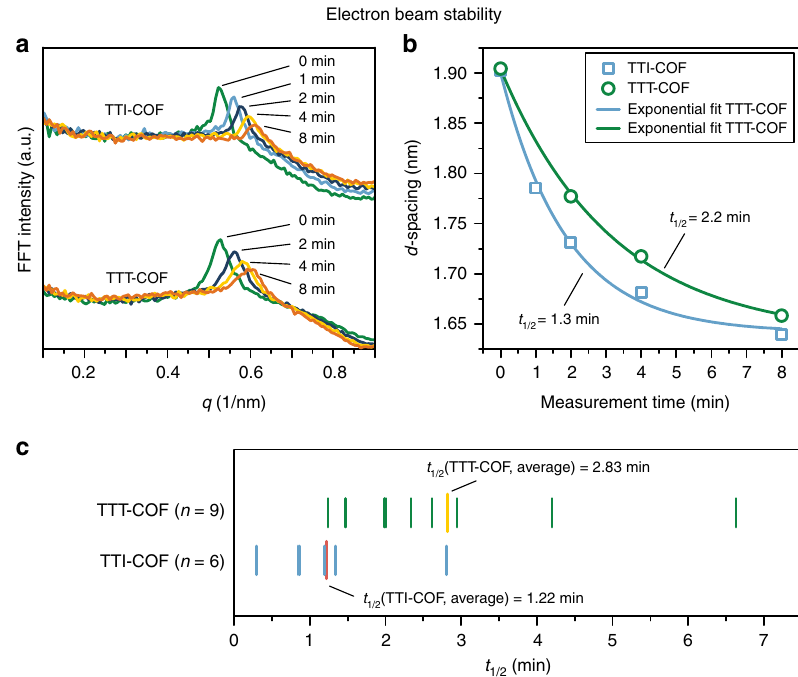
Fig. 5 Electron beam stability tests of the TTI- and TTT-COFs. a Electron beam damage seen by the broadening and a shift of the peak in the FFT, corresponding to the 100 re fl ection in XRPD, of TEM images taken after different exposure times. b Plotting the exposure time against the peak shift in the FFT shows a decay that can be fi tted with an exponential ( fi t parameters shown in Supplementary Table 10). c Several sets of images were analyzed this way and the results are depicted graphically for better comparison. The average half-life of each system reveals the higher stability of the TTT-COF as compared to